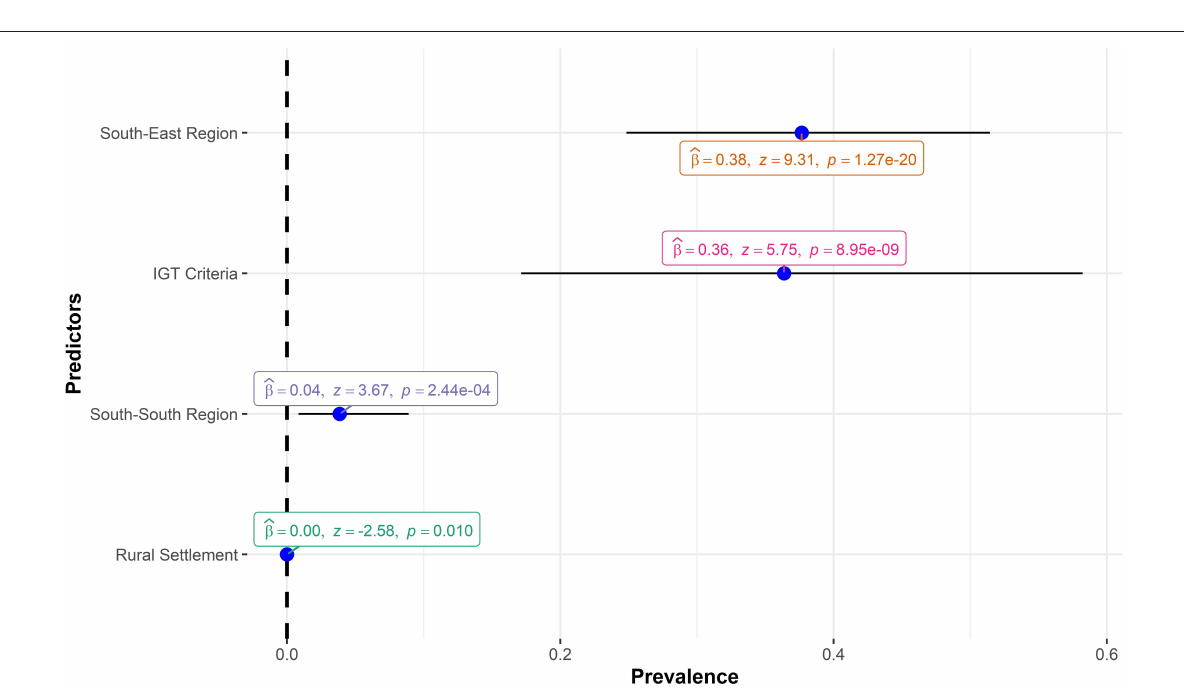
FIGURE 6 | Regression coefficients of the WHO criteria